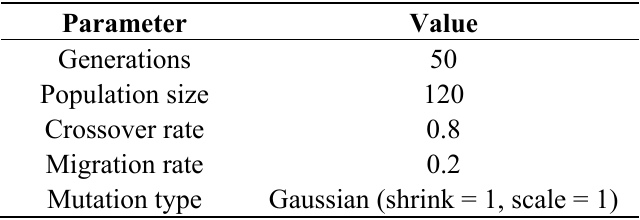
Table 9. Parameter settings of the genetic algorithm.